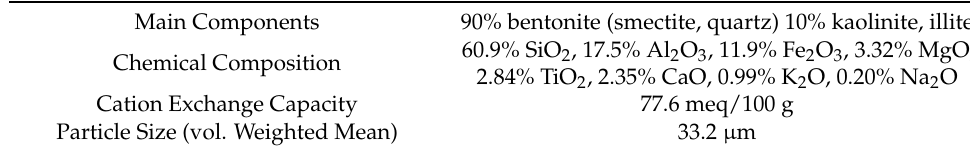
Table 1. Characteristics of the clay mineral mixture.